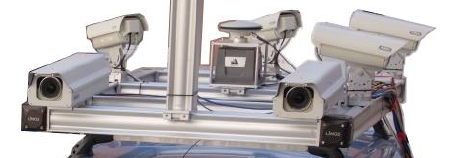
Figure 2. Sensor configuration of our vehicle-based mobile mapping system (Cavegn et al., 2018)